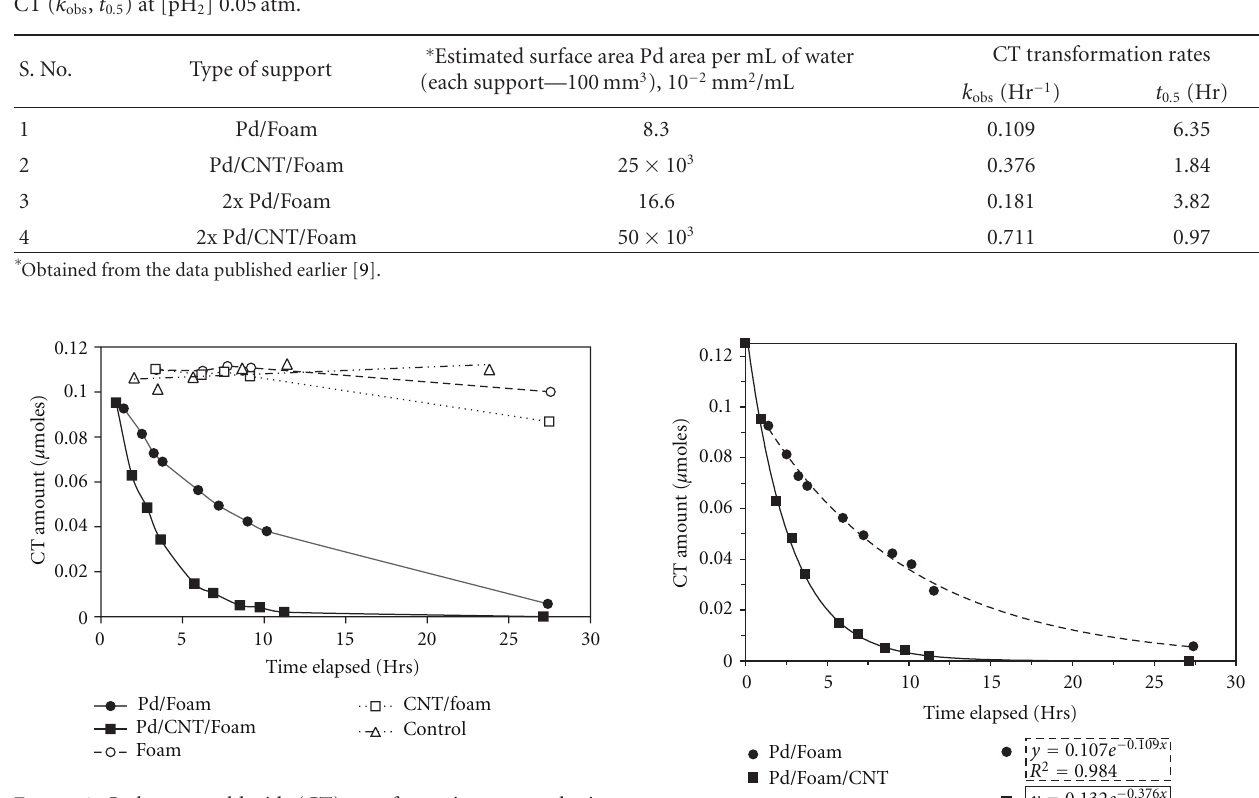
Figure 2: Carbon tetrachloride (CT) transformation curves obtain- ed with various types of catalyst supports.